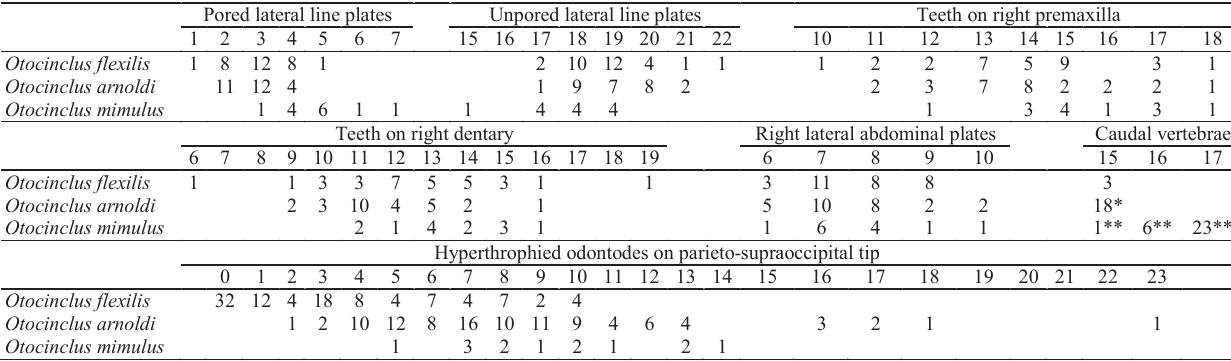
Table 2. Frequency distribution of variable counts of Otocinclus species. Caudal vertebrae counted in clear and stained specimens only. *Five specimens counted and 13 from radiographs by S.O. Kulander; **Data from radiographs by S. O.